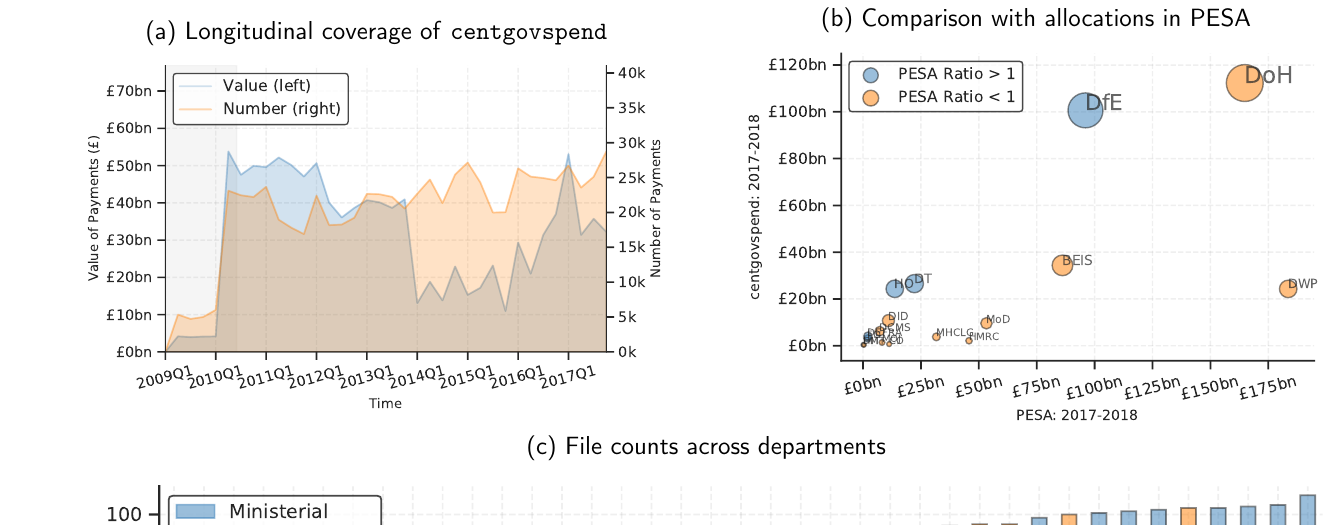
Figure 3: Evaluation, validation and diagnosis of centgovspend outputs